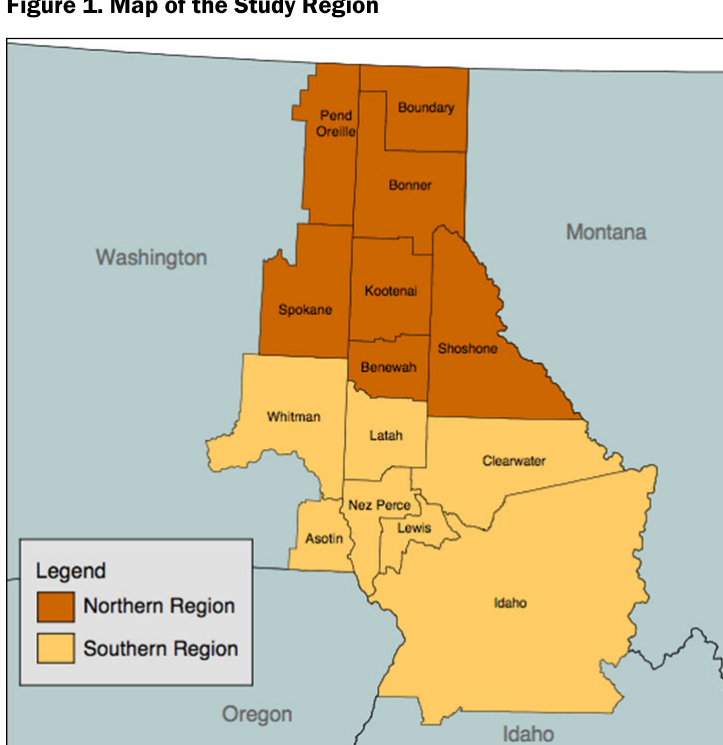
Figure 1. Map of the Study